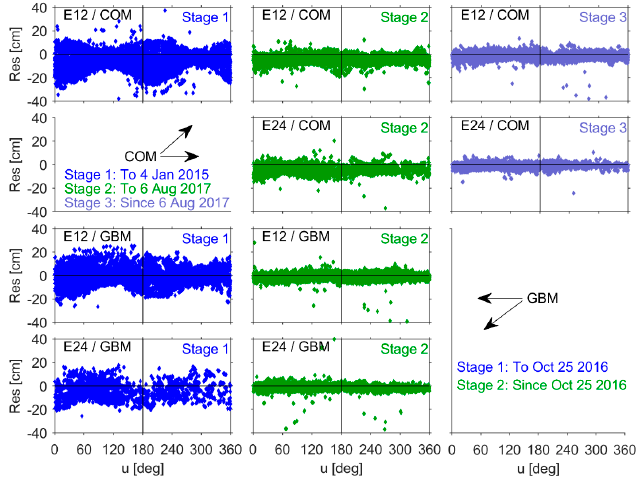
Figure 10. SLR residuals as a function of the argument of latitude u. Prior to the update, SLR residuals also exhibited a clear dependence on the argument of satellite latitude with respect to the Sun